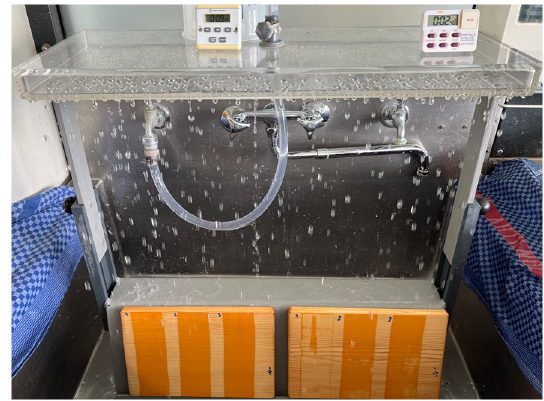
Figure A2. Setup for early rain resistance testing for wood paints.